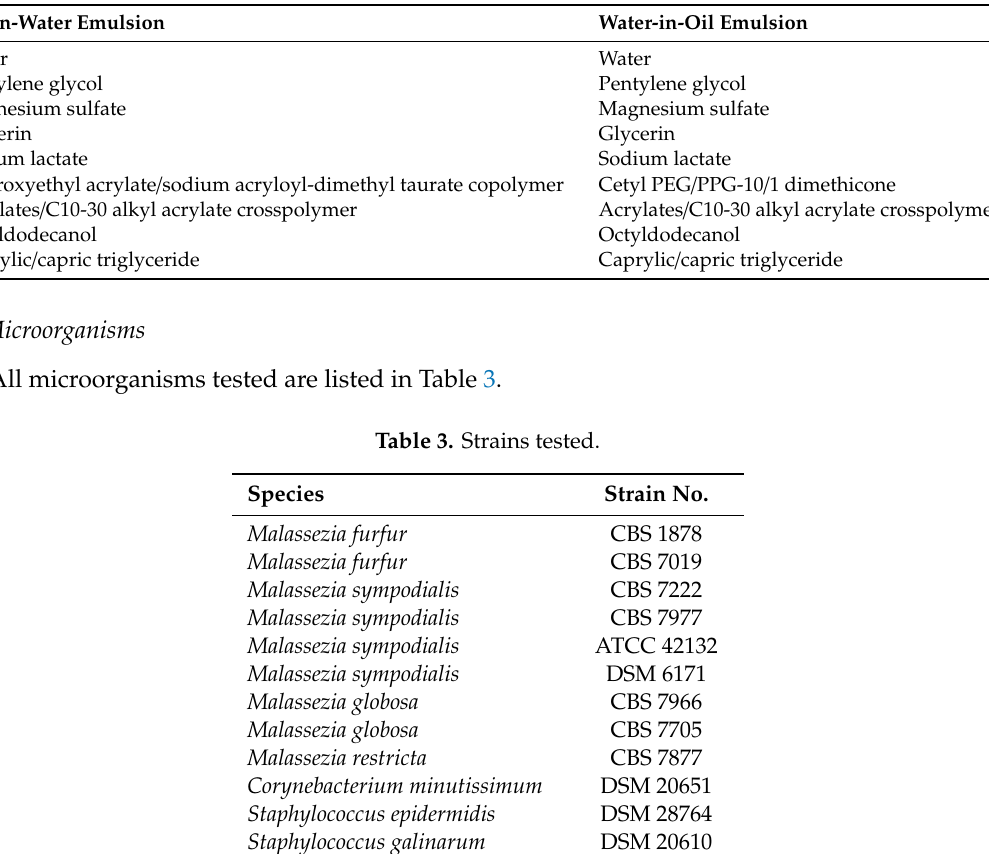
Table 2. Composition of the tested emulsions.